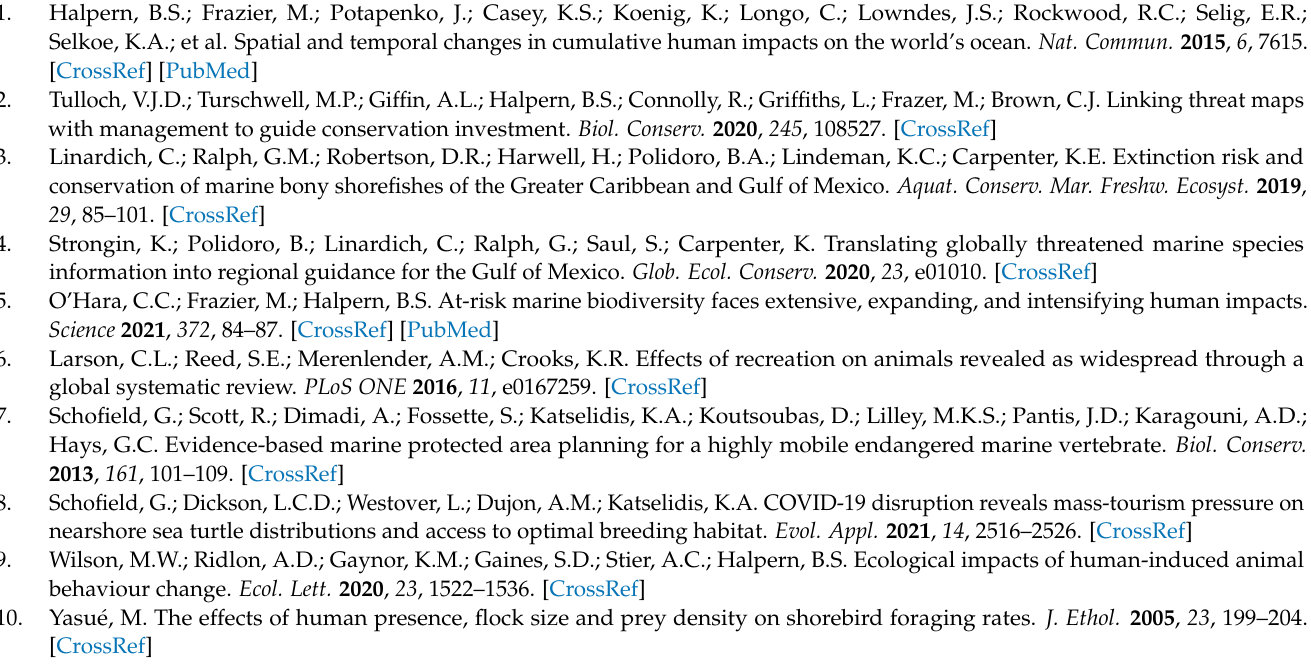
Figure A7. State-space model (SSM) points of Turtle #39, a loggerhead turtle ( Caretta caretta ) that migrated from the Florida Keys National Marine Sanctuary to the southeast Florida coast and then back via the Florida Straits between 5 March and 11 May 2020. Each color represents the number of unique high threat categories encountered on that given day within a 2 km buffer of the SSM point.